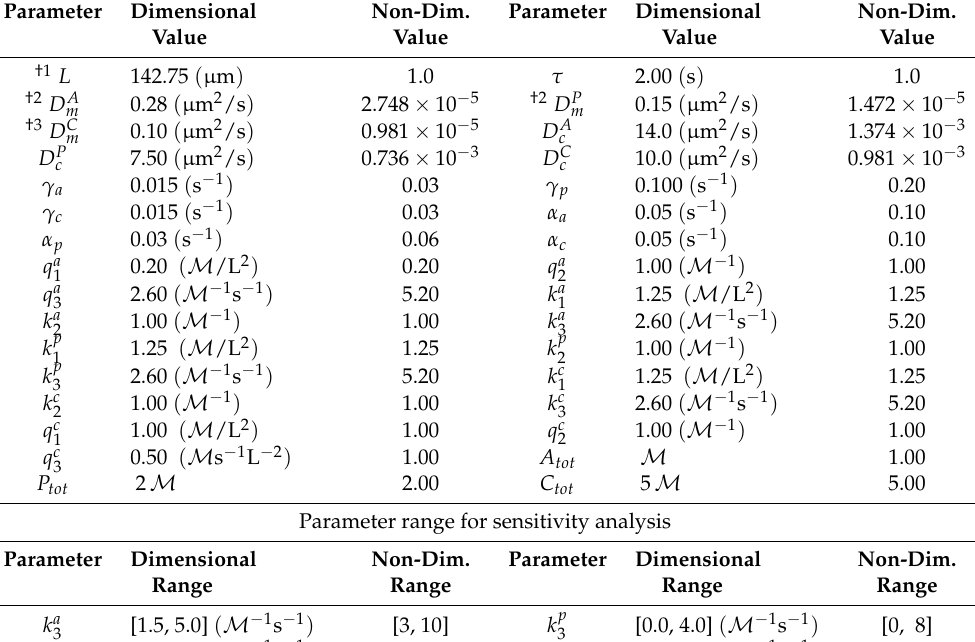
, q a , q a only via the 2 3 1